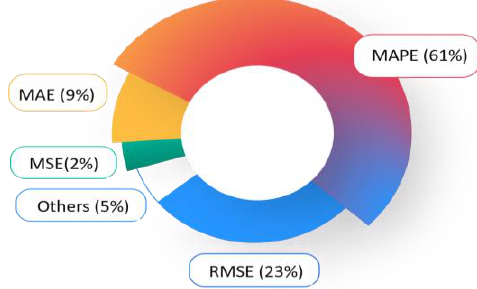
Figure 19. Classification by types of errors.